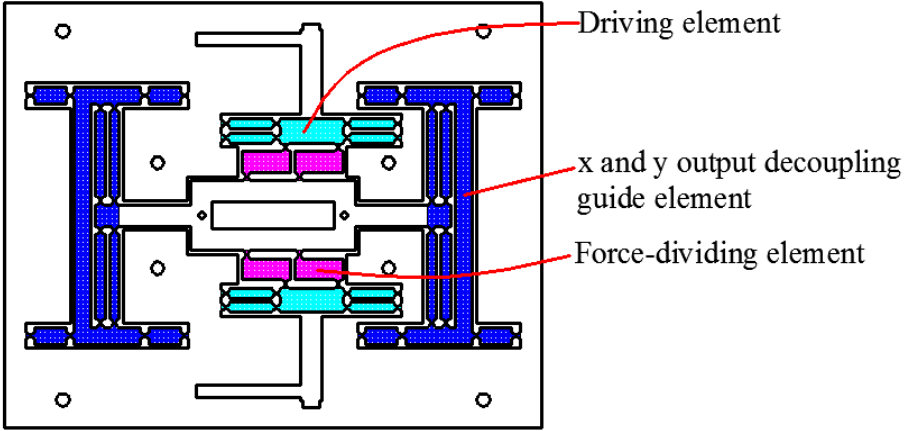
Figure 1. Schematic of a three degrees of freedom (3-DOF) motion device. ( a ) Overall design of the system; ( b ) two-dimensional (2D) motion platform ( x and y directions); ( c ) flexible-hinge with z direction.